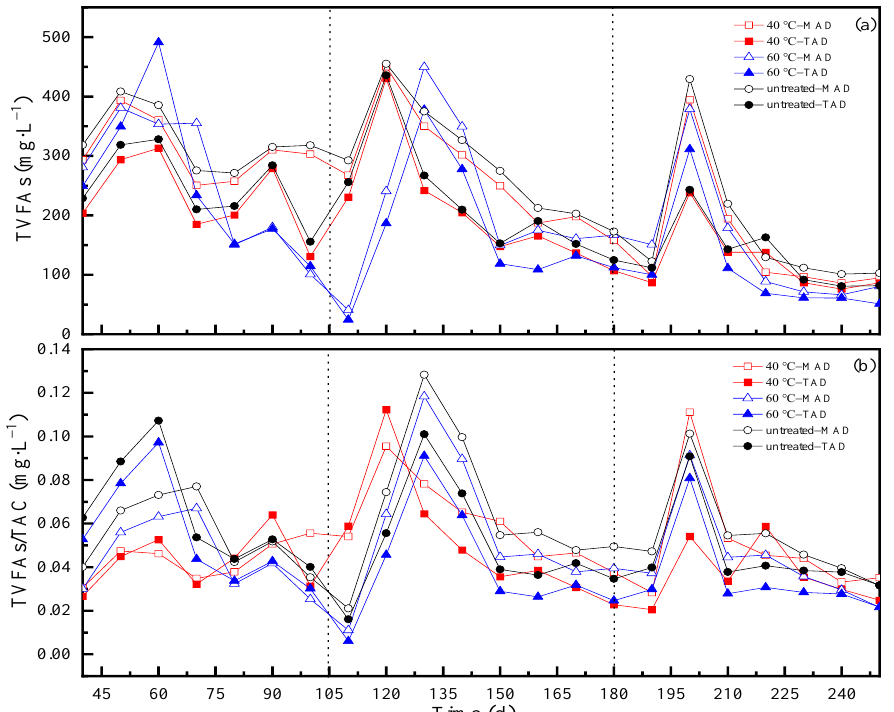
Figure 5. ( a , b ). The TVFAs and TVFAs/TAC of different pretreatment and anaerobic digestion temperatures. ( a ): TVFAs; ( b ): TVFAs/TAC. The ratio of TVFAs/TAC can be applied to evaluate the buffer ability of anaerobic digestion. Generally, the digestion process could keep stable when the ratio of TVFAs/TAC is below 0.4, and however, the system shows instability when the ratio exceeds 0.8 [53]. TVFAs and TVFAs/TAC of this work were shown in Figure 5b. The results showed that the ratios of VFA to alkalinity ration of the effluents from six reactors were from 0.01 to 0.2. This showed that the operating condition in each CSTR was at optimum level. It can be seen that the TVFAs/TAC of untreated group in both AD temperature systems during the three OLRs showed relatively high. This demonstrated that pretreated CS can more easily maintain the system stability during the AD process. Furthermore, the TVFAs/TAC of TAD was lower than MAD during the last two OLRs, which indicated that TAD showed better buffer ability at high OLR.